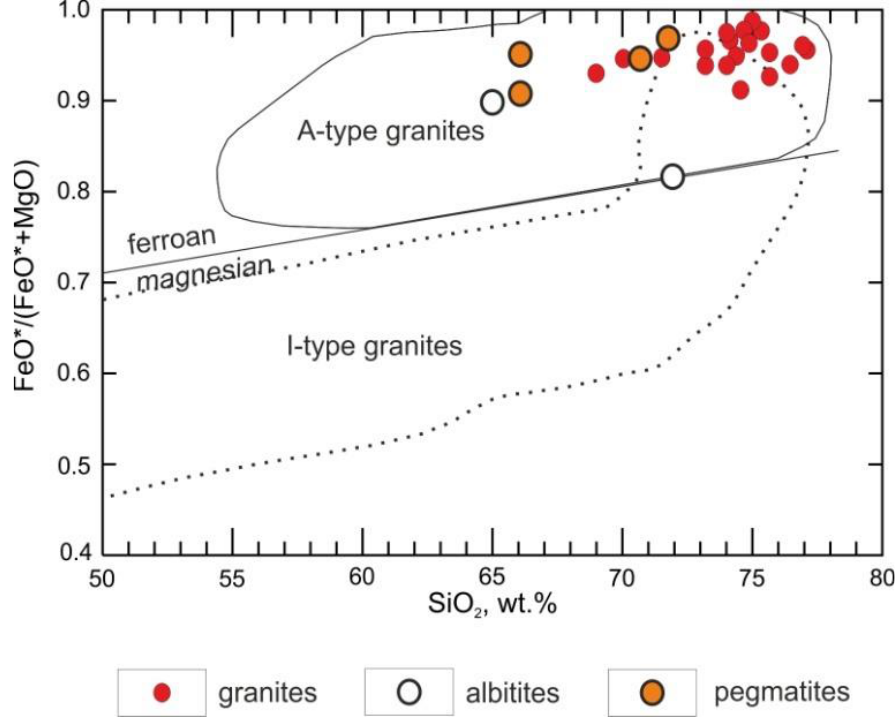
Figure 12. FeO*/(FeO*+ MgO) vs. SiO 2 diagram [58] for rocks of the Somnitelnyi massif and Tommot deposit.